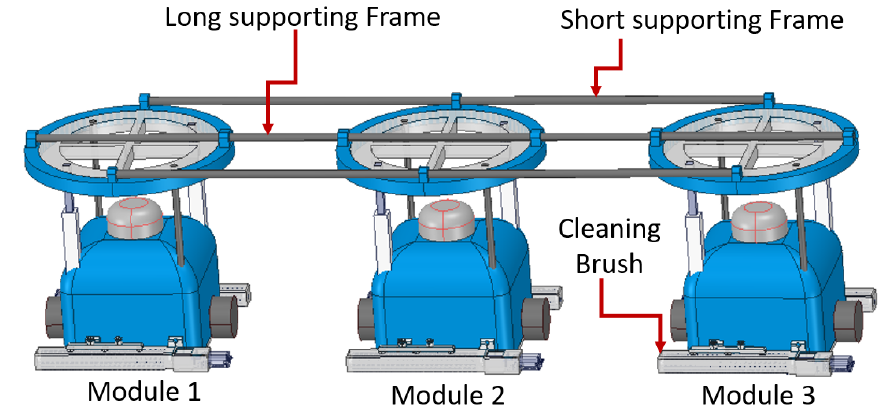
Figure 2. CAD model of the entire